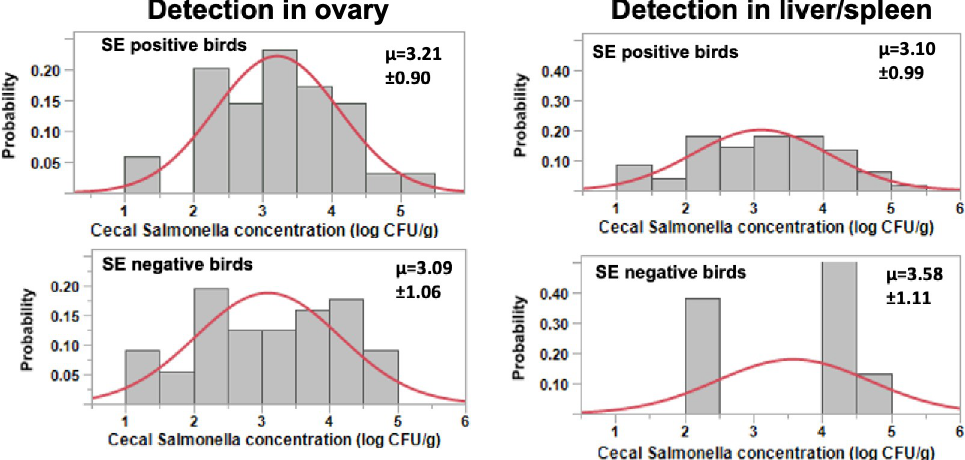
Fig 2. Cecal Salmonella concentration (log 10 CFU/g) distributions in Salmonella positive and negative samples from the ovary and liver/spleen of 17 week-old layers 1 week after direct challenge with S . Enteritidis. The bar graphs show the frequency of each concentration range while the red line shows the normal distribution curve based on the observed concentration. Detection was based on the occurrence of Salmonella in the tissue as determined by growth after plating on XLT-4 agar plates containing 25 μ g of nalidixic acid/mL. μ represents the mean log 10 concentration ± the standard deviation.